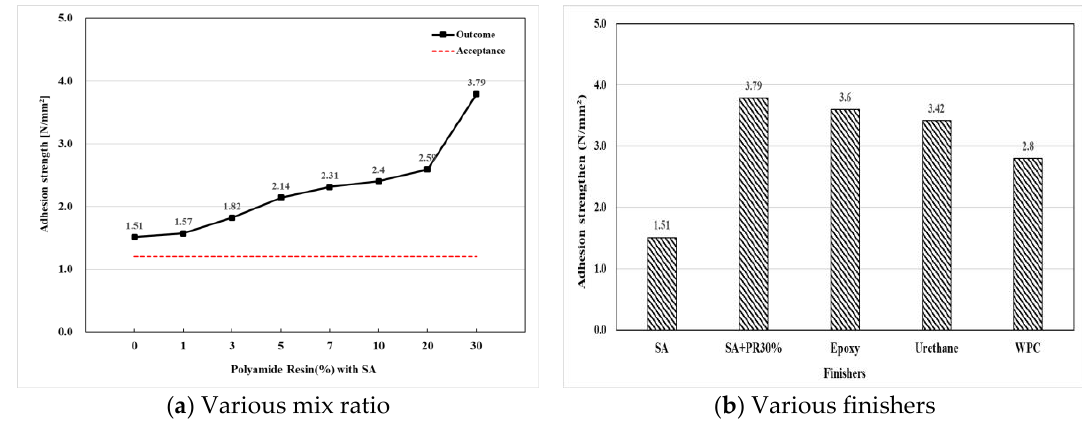
Figure 7. Adhesion strength.